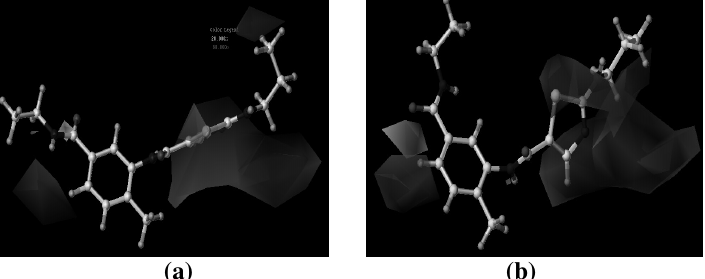
Figure 9. CoMSIA S.D. * coefficient contour maps illustrating hydrophobic features in combination with compound 2g. a) Ligand based and (b) Receptor based. The magenta contour for hydrophobic favored region, gray indicates the hydrophilic favored